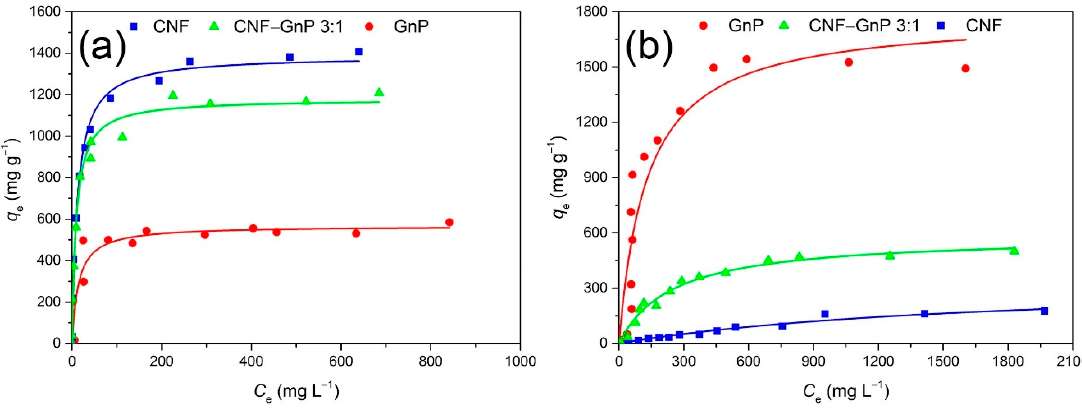
Figure 6. Adsorption of MB ( a ) and CR ( b ) to CNF, CNF–GnP and GnP. The Langmuir adsorption model was applied for data fitting.